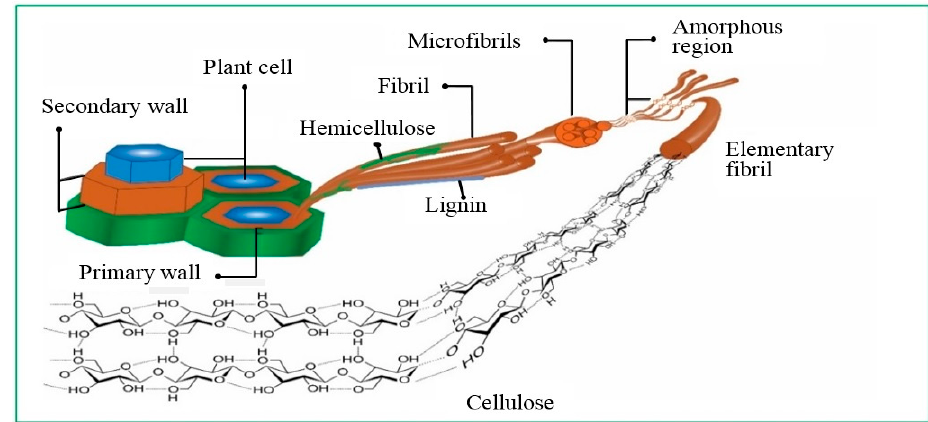
Figure 1. Graphical illustration of the hierarchical structure of cellulose extracted from plants.